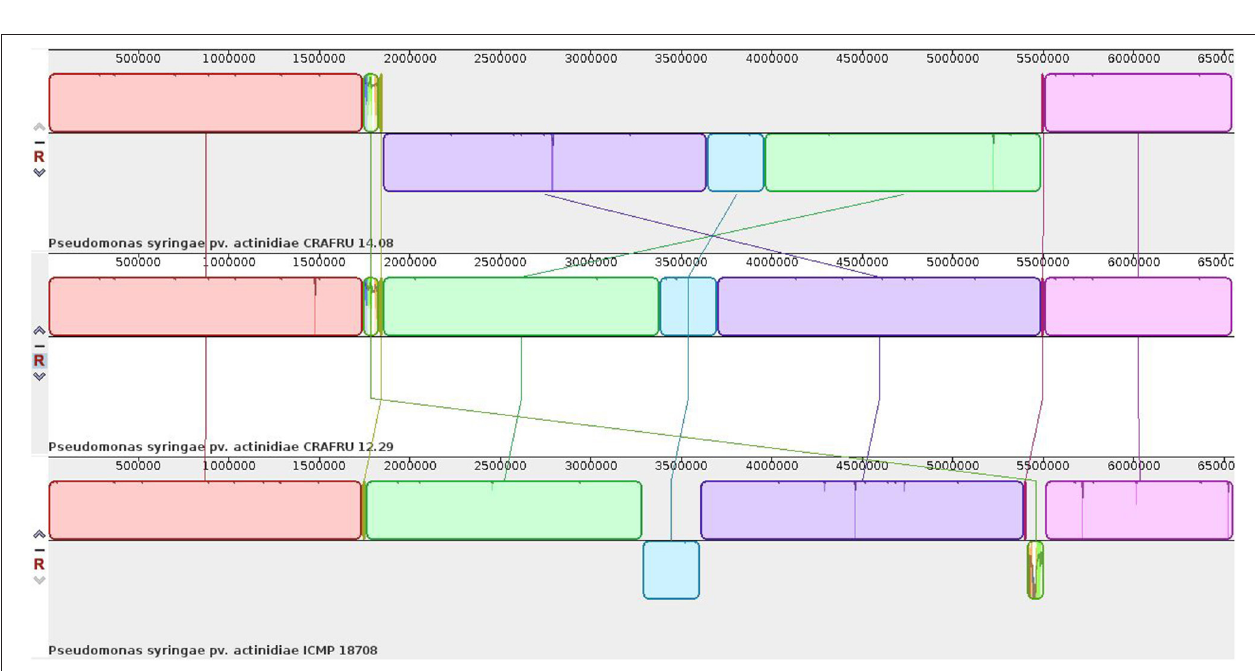
FIGURE 2 | Mauve alignment of the chromosomes of strains CRAFRU 14.08, CRAFRU 12.29, and ICMP